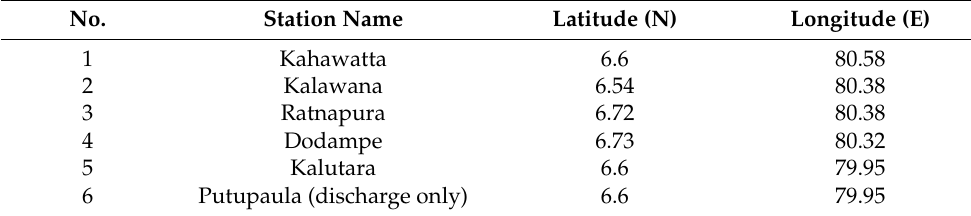
Table 1. Coordinates of the rainfall and discharge gauge